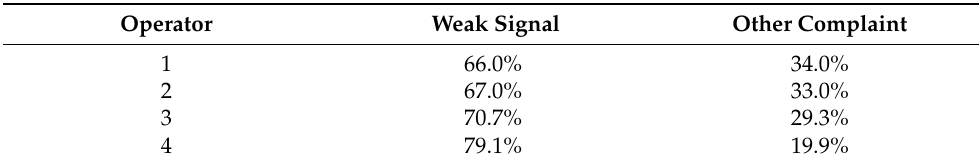
Table 2. Main complaints detection in the OSN about the telecommunications services offered by the four selected telecommunications